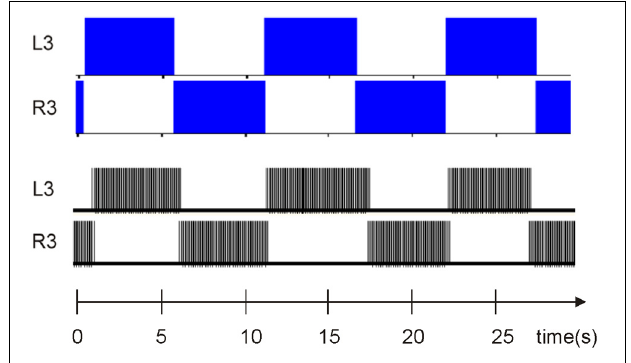
FIGURE 5 | Comparison between elemental oscillator (Figure 1B) bursting activity in the complex model simulated by scilab, as described in Hill et al. (2001) and the elemental oscillator presented above thanks to a logic analyzer. The time scale is the same.